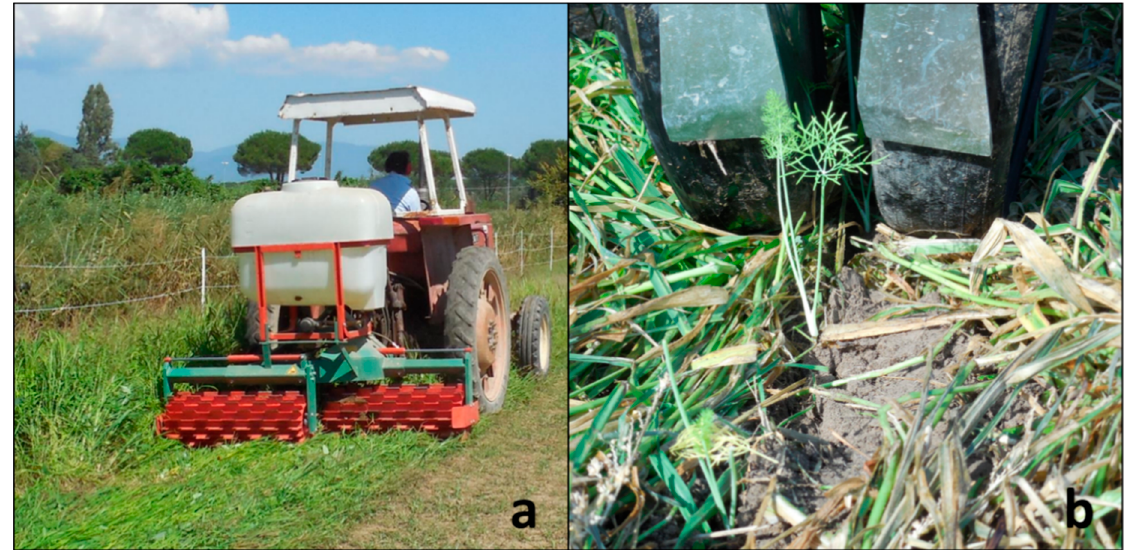
Figure 5. Clemens ballasted crimper roll (Clemens technologies, Wittlich, Germany) used to terminate a cover constituted by a mixture of rye and vetch at Pisa University at work ( a ) and detail of a well transplanted plant of fennel on the rolled cover with the transplanter developed at the University of Pisa ( b ).